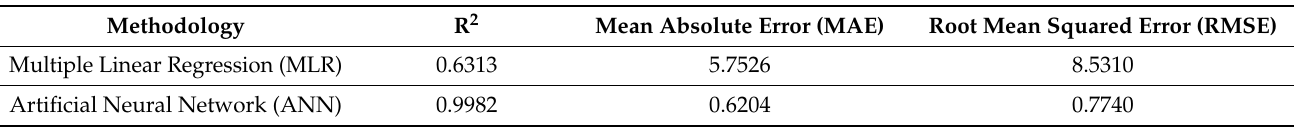
Table 3. Performance measures of each